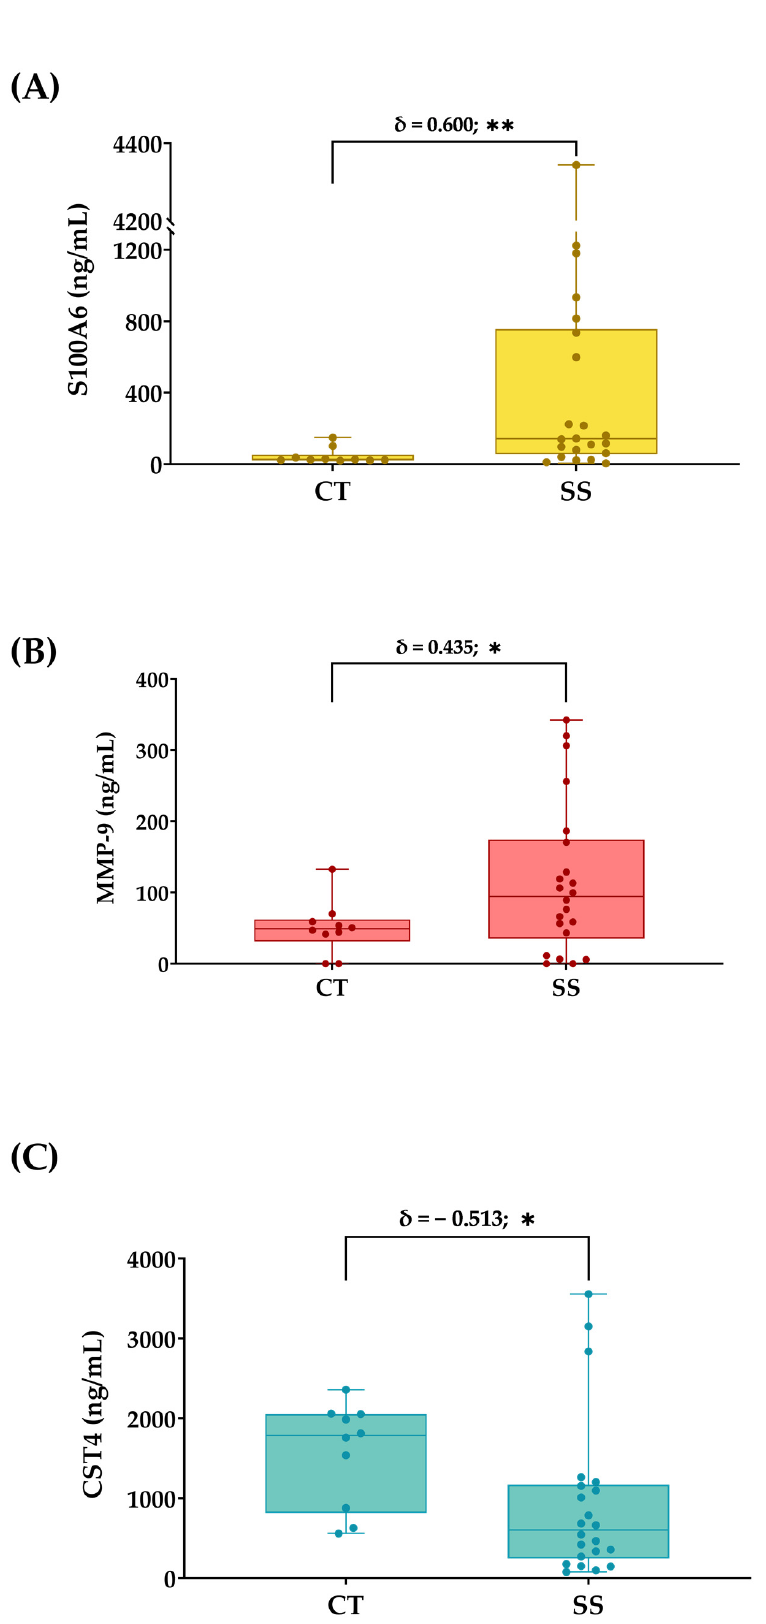
Figure 2. Tear S100A6 ( A ), MMP-9 ( B ) and CST4 ( C ) concentrations (ng/mL) in the groups of patients su ff ering SS relative to the healthy controls (CTs). Cli ff ’s delta values are displayed for each comparison. In addition, statistical signi fi cances are displayed: *, p < 0.05; **, p < 0.01.